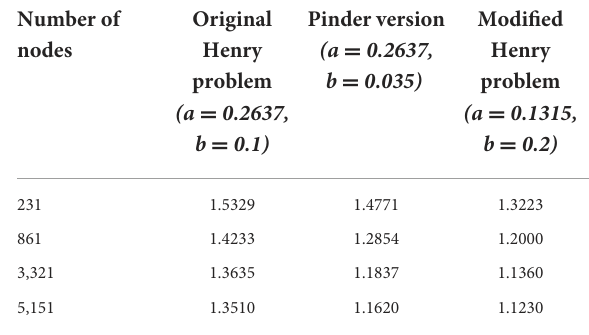
TABLE 1 Toe position for the isochlor C = 0.5, using different number of nodes.